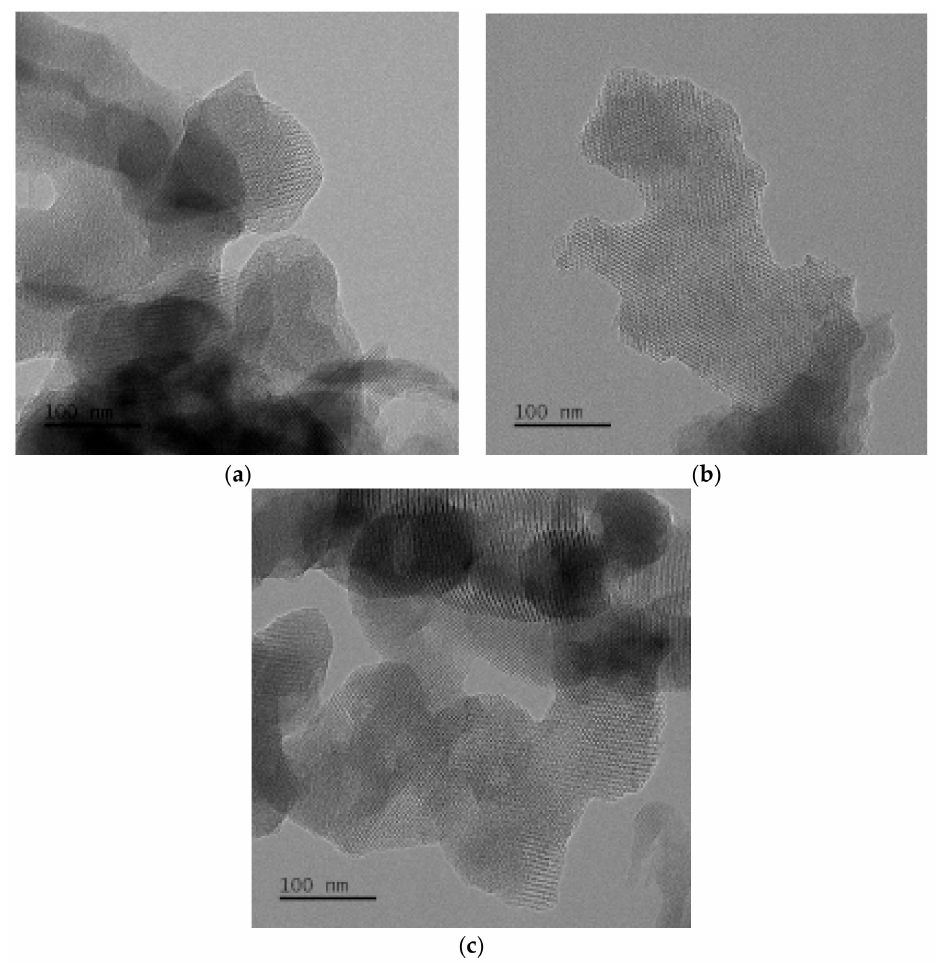
Figure 8. TEM images of MCM-41s: ( a ) MCM-41(0.1); ( b ) MCM-41(0.2); ( c )